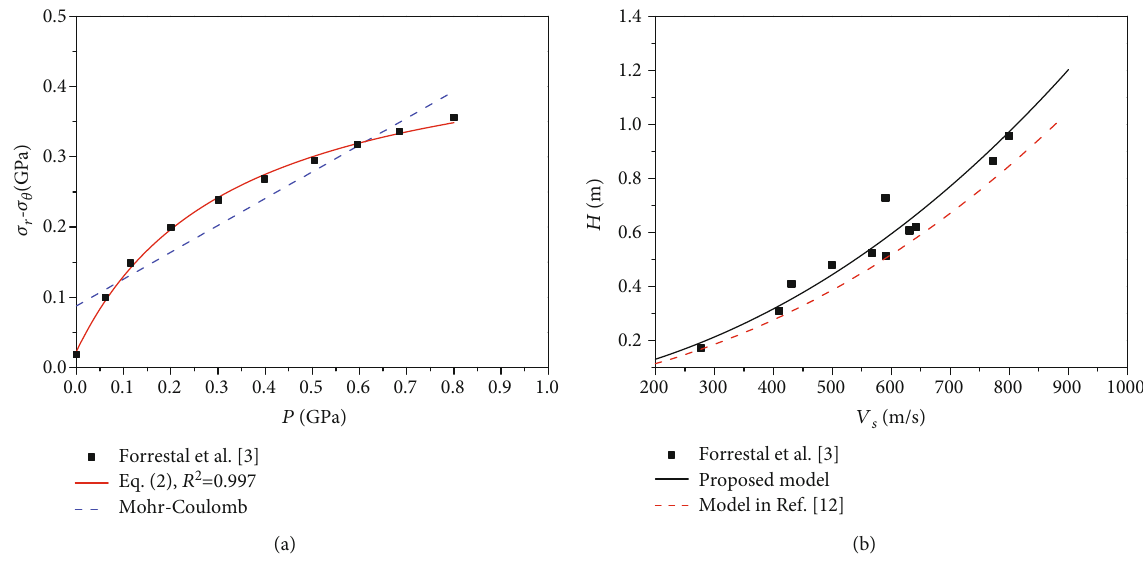
Figure 6: Comparison of theoretical model and test data for 36 MPa concrete: (a) yield criterion and (b) DOP.